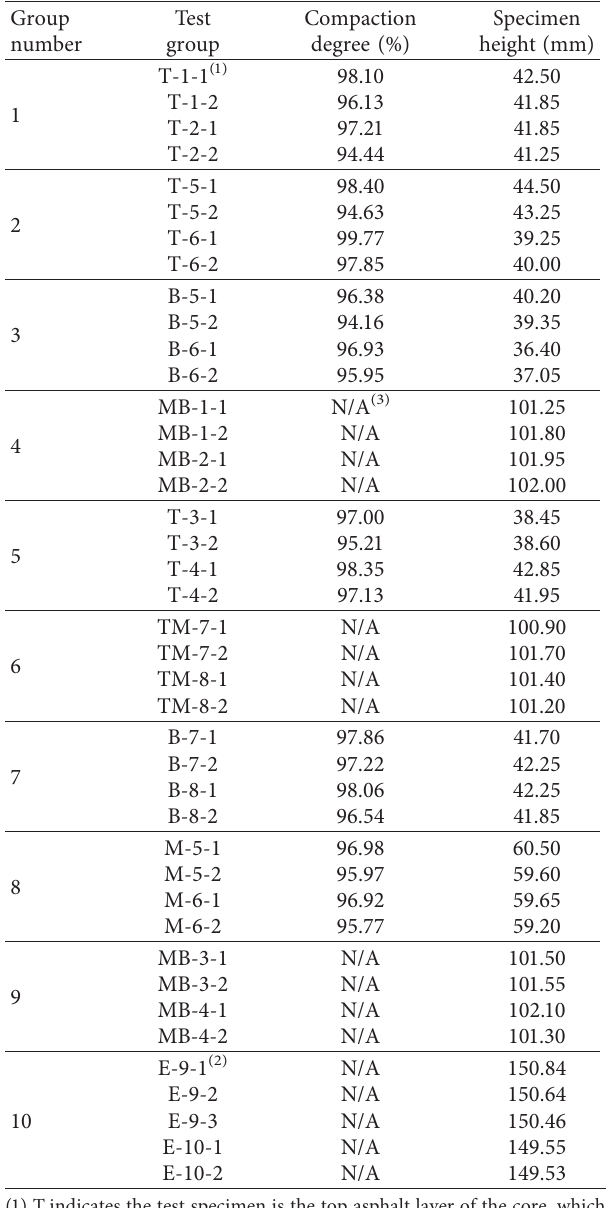
Table 2: Information of